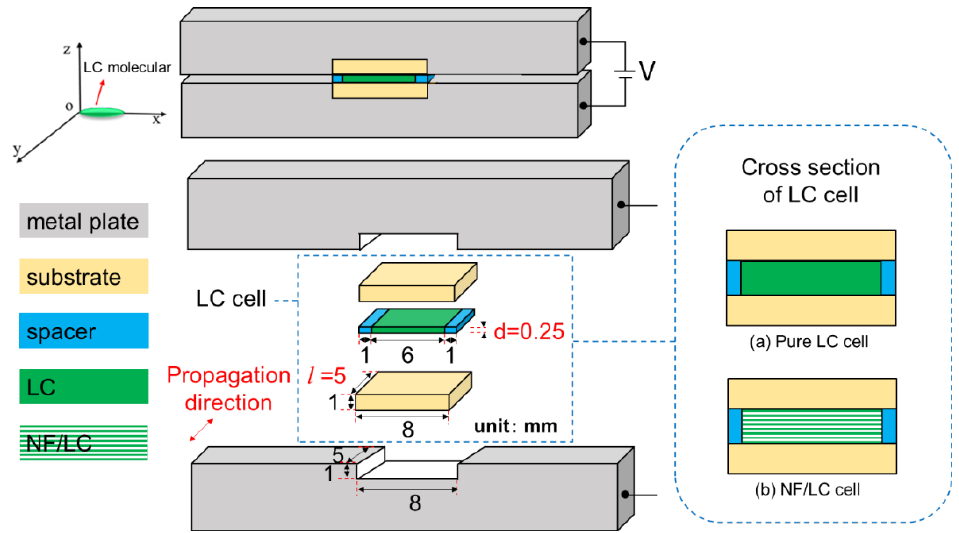
Figure 3. Structure of liquid crystal-loaded NRD waveguided terahertz wave phase shifter and cross-sections of ( a ) pure liquid crystal (LC) cell and ( b ) nanofiber (NF)/LC cell.